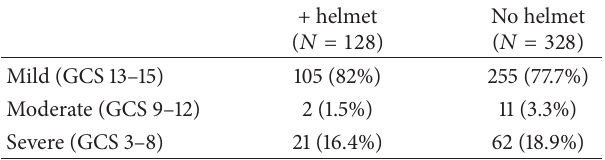
Table 6: TBI severity and symptoms at injury based on helmet use.